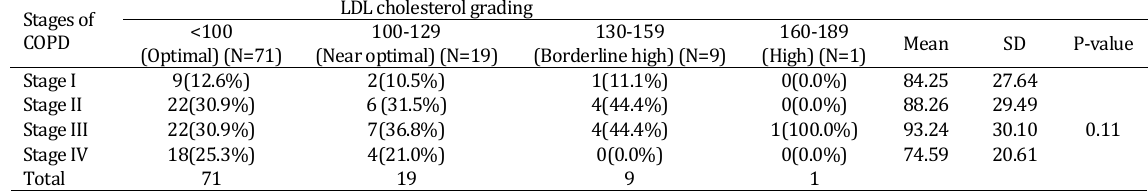
Table 5. Triglycerides in relation to chronic obstructive pulmonary disease stages Stages of